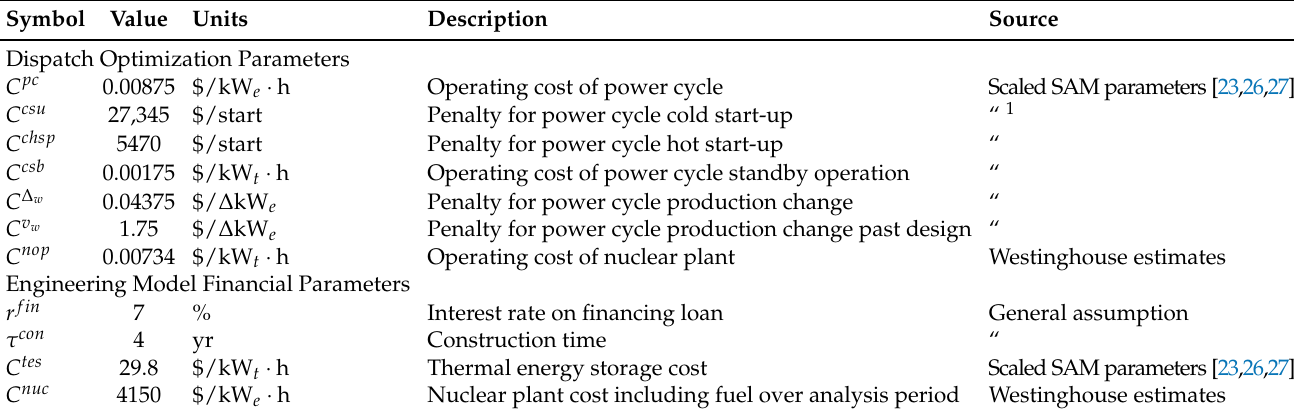
Table 1. Costs and other parameters used for evaluating plant economic performance.